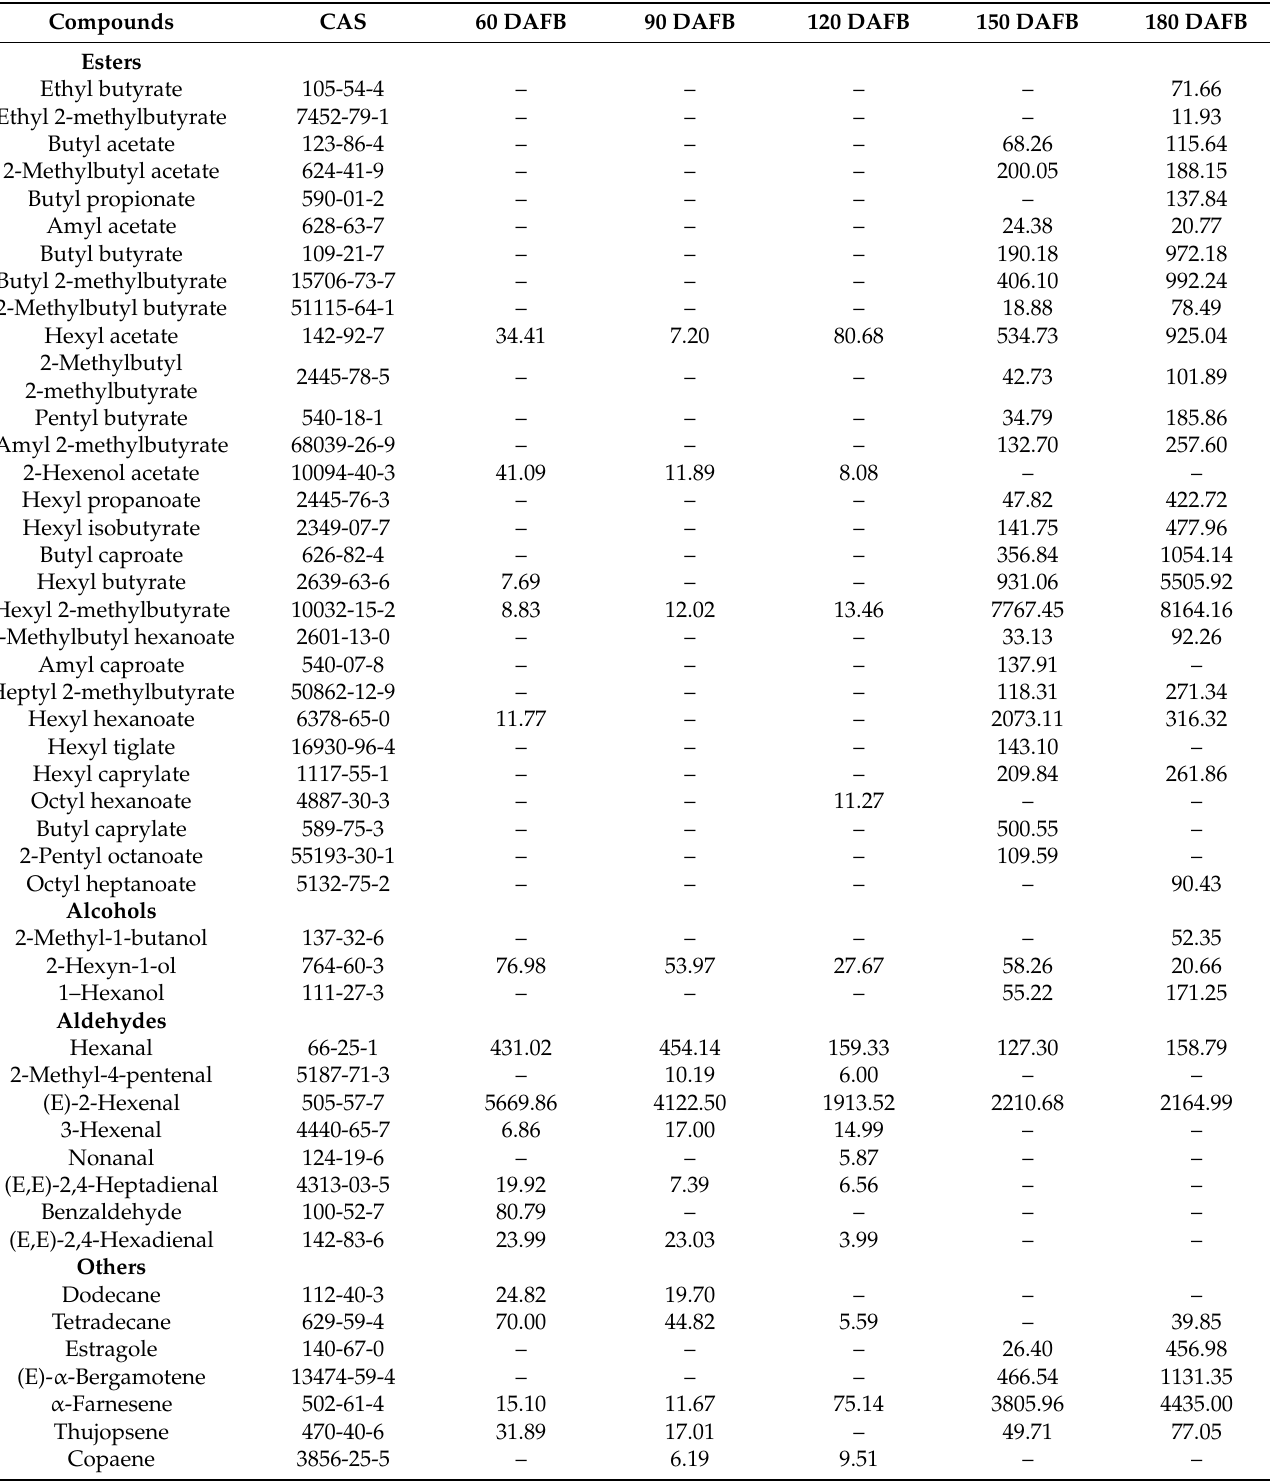
Table 3. The content ( µ g/kg FW) of volatile compounds in ‘Orin’ apple peels at different ripening